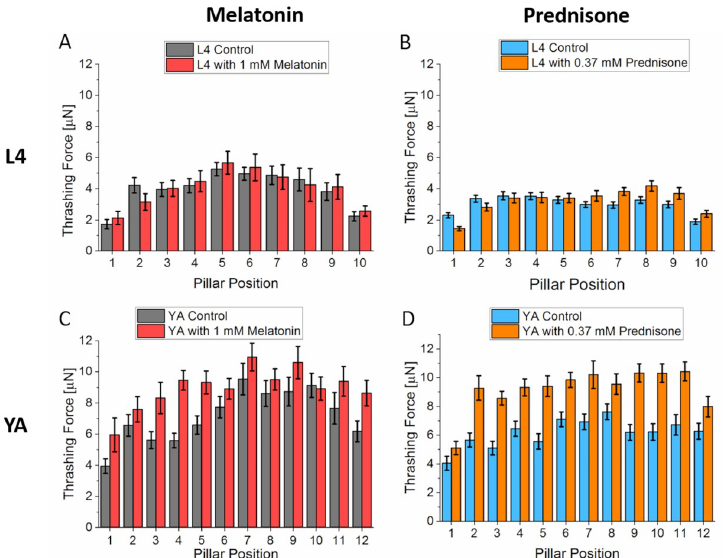
Fig 2. Thrashing force assay in DMD model worm (LS587). (A) L4 stage DMD model worms did not show any significant change in thrashing force when treated with 1 mM melatonin (N = 25, p > 0.05). (B) Prednisone treatment on L4 model worms also did not show any change in thrashing force (N = 25, p > 0.05). (C) Young adult worms treated with 1 mM melatonin showed significant improvement in thrashing force exerted across all the micropillars when compared to control worms which were not treated (N = 25, P < 0.0001). (D) Prednisone treatment also increased the thrashing force of young adult worms compared to worms without any treatment (N = 25, p < 0.00001). Significant differences were analyzed using the two-way ANOVA with Tukey’s multiple comparison between average force values of control and treated worms, error bars indicate s.e.m.